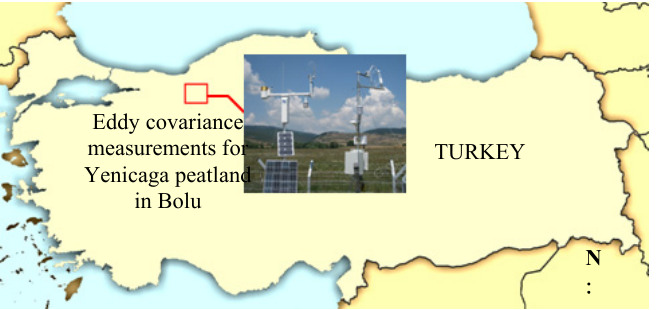
Figure 1. Location of the study site “Yenicaga peatland” in northwestern